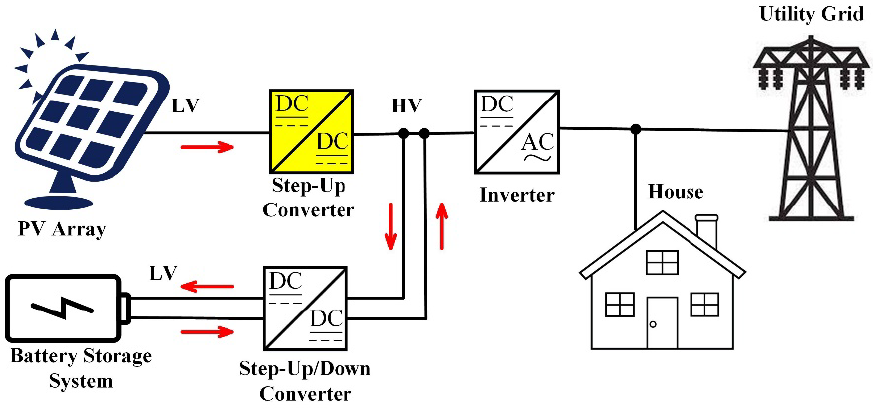
Figure 1. Block diagram of a grid-connected PV system.